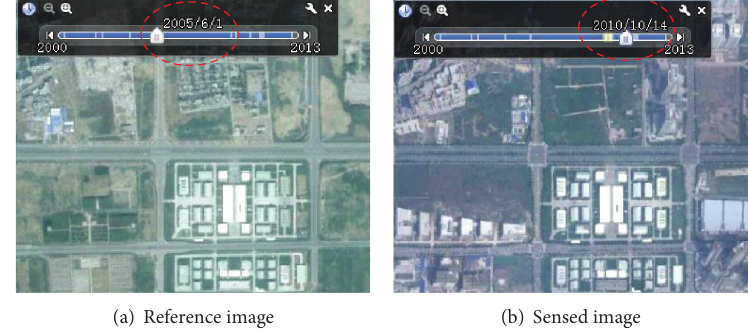
Figure 5: Data source from Google Earth.